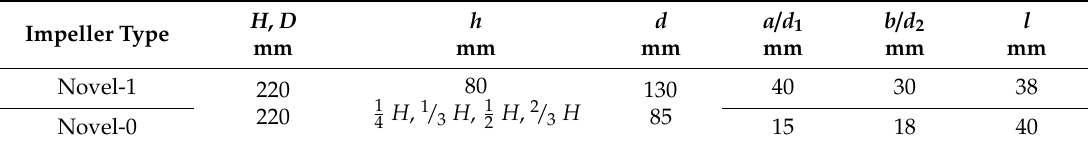
Figure 2. The geometry of stirred tank with ( a ) Novel-1 impeller (squire type) and ( b ) Novel-0 impeller (round type). The top figure is the side view and the bottom one is the top view. Table 2. Dimensions of the stirred tank and Novel impellers.